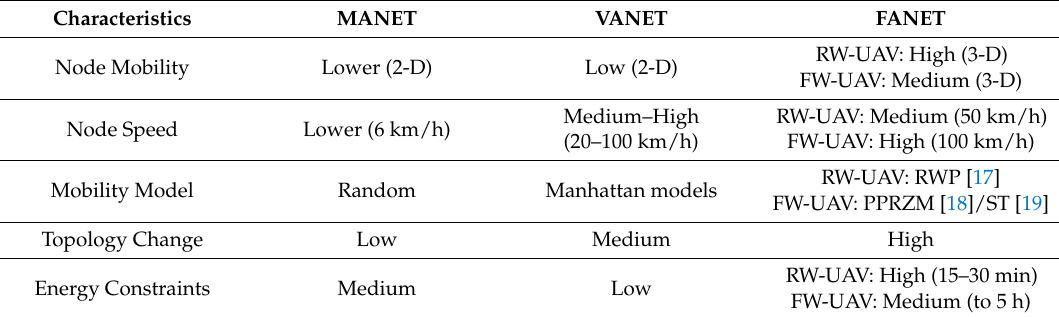
Table 2. Comparison of MANET, VANET, and